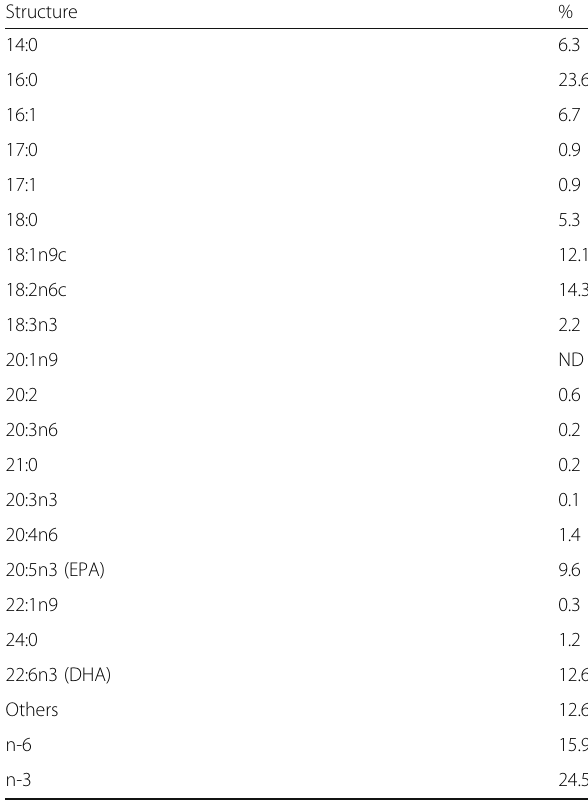
Table 2 Percentage of fatty acids in utilized fish oil Structure